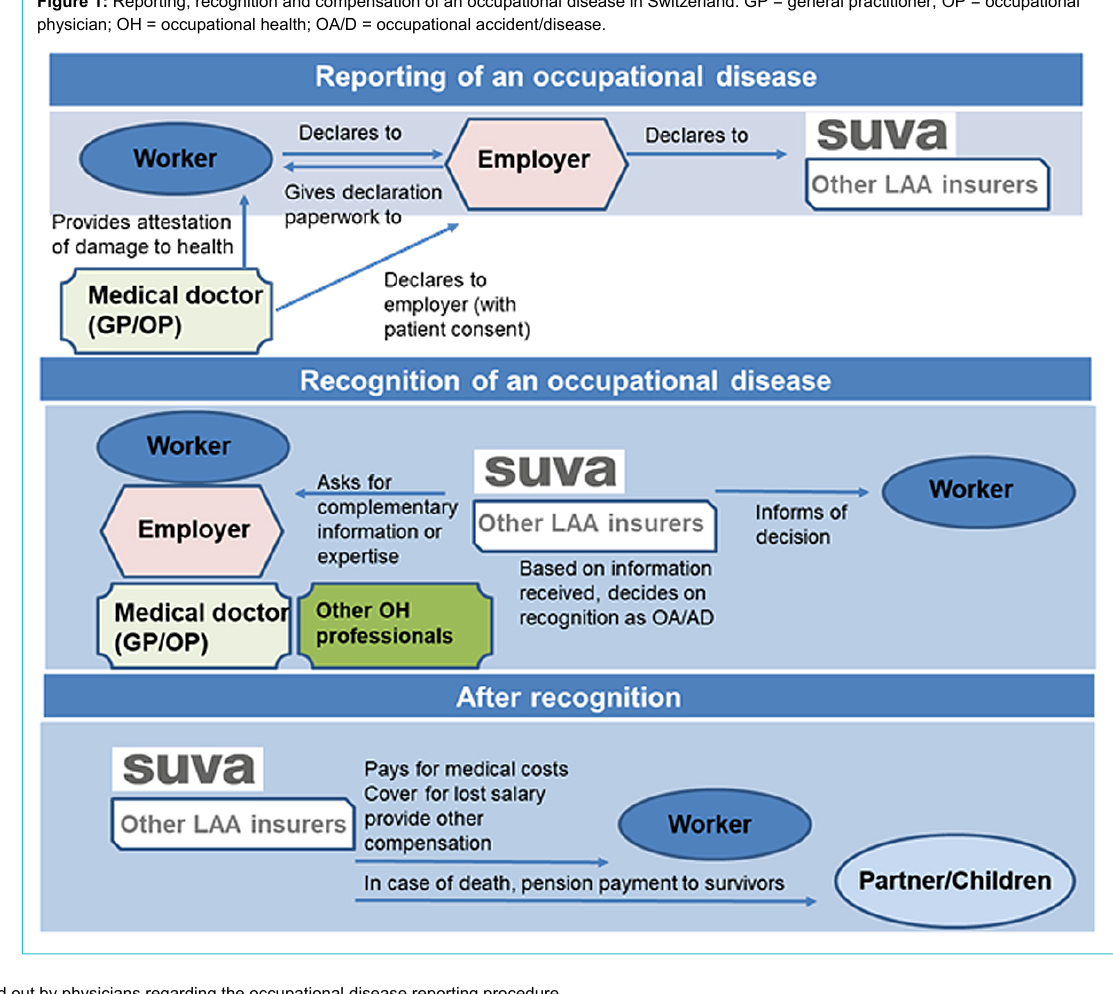
Table 2: Challenges pointed out by physicians regarding the occupational disease reporting procedure. General lack of training and information on occupational risk factors Lack of knowledge among workers on occupational risk factors and their